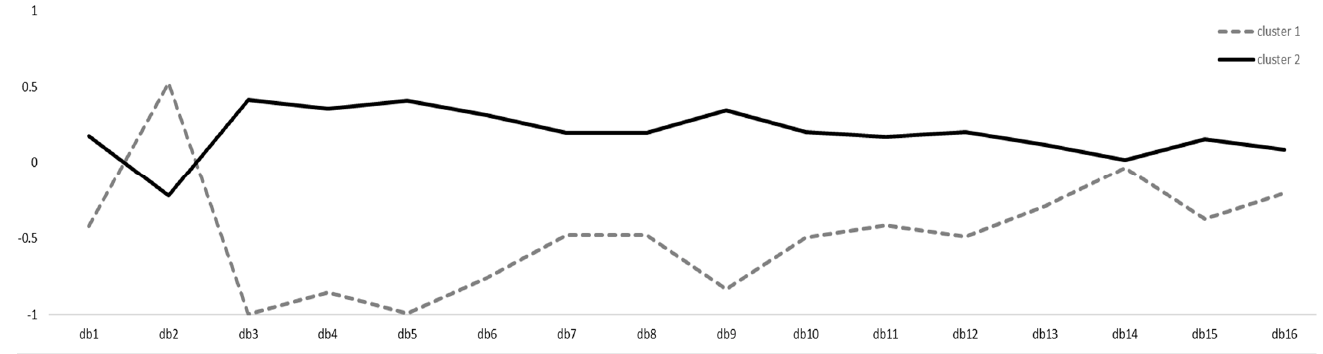
Figure 2. Cluster distribution over 16 GDBI-E items. The graph illustrates the distribution of the 16 GDBI-E items for the two clusters on a z-standardized scale. The two clusters represent a dichoto- mous scale (mainly less healthy and a mainly healthy dietary behavior).